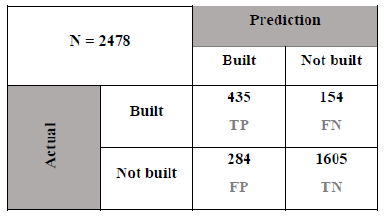
Table 5. Accuracy assessment for Jan. 14, 2017